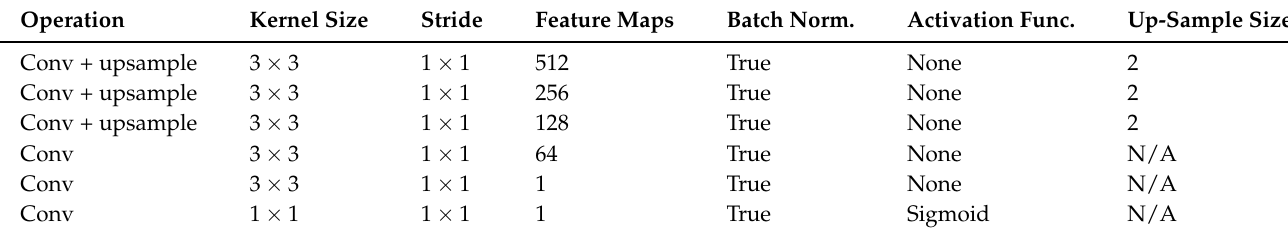
Table 2. Architecture of SegNet’s